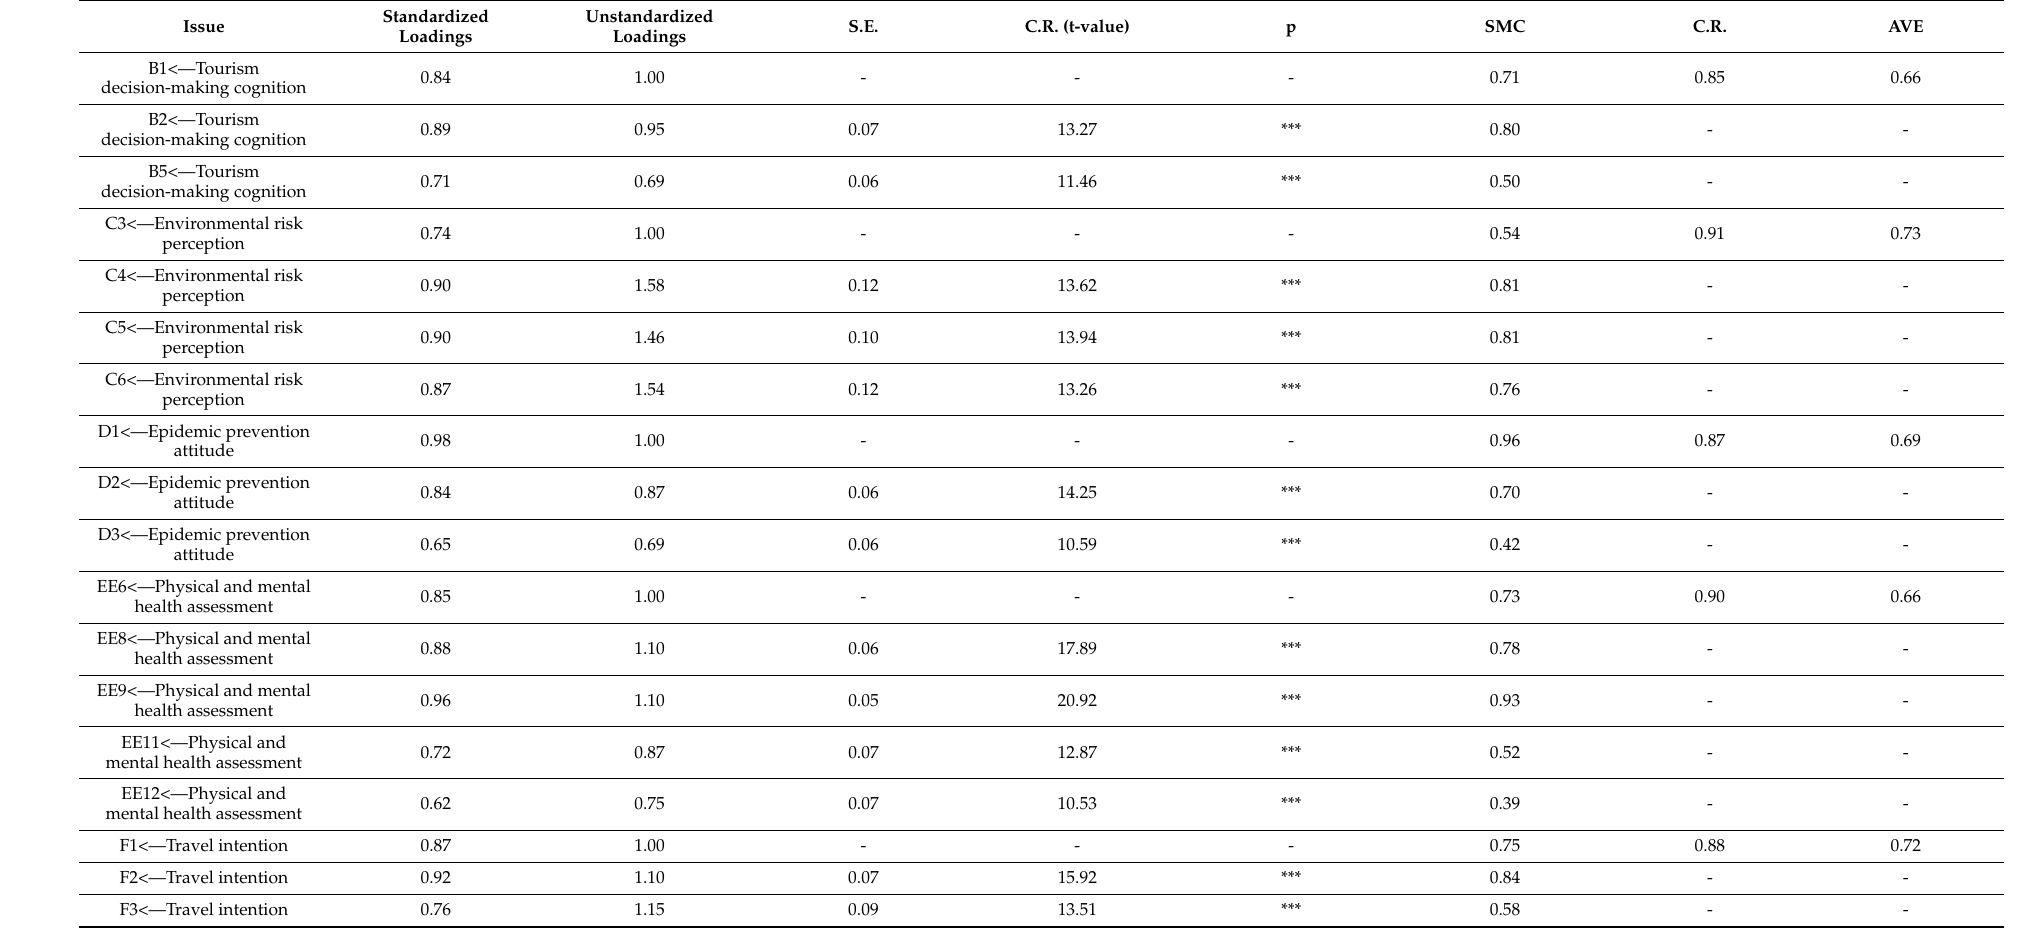
Table 4. Convergent validity and construct reliability of this